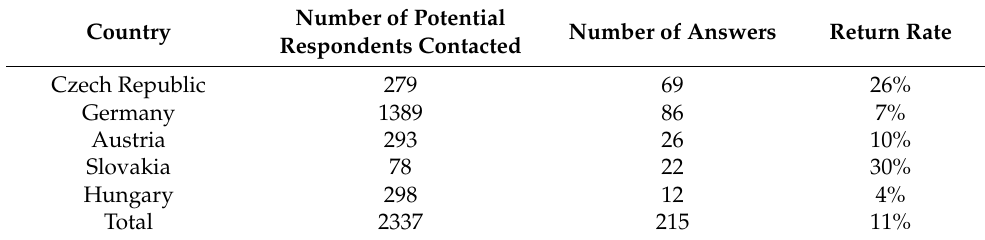
Table 6. Questionnaire return rate in participating EU countries.